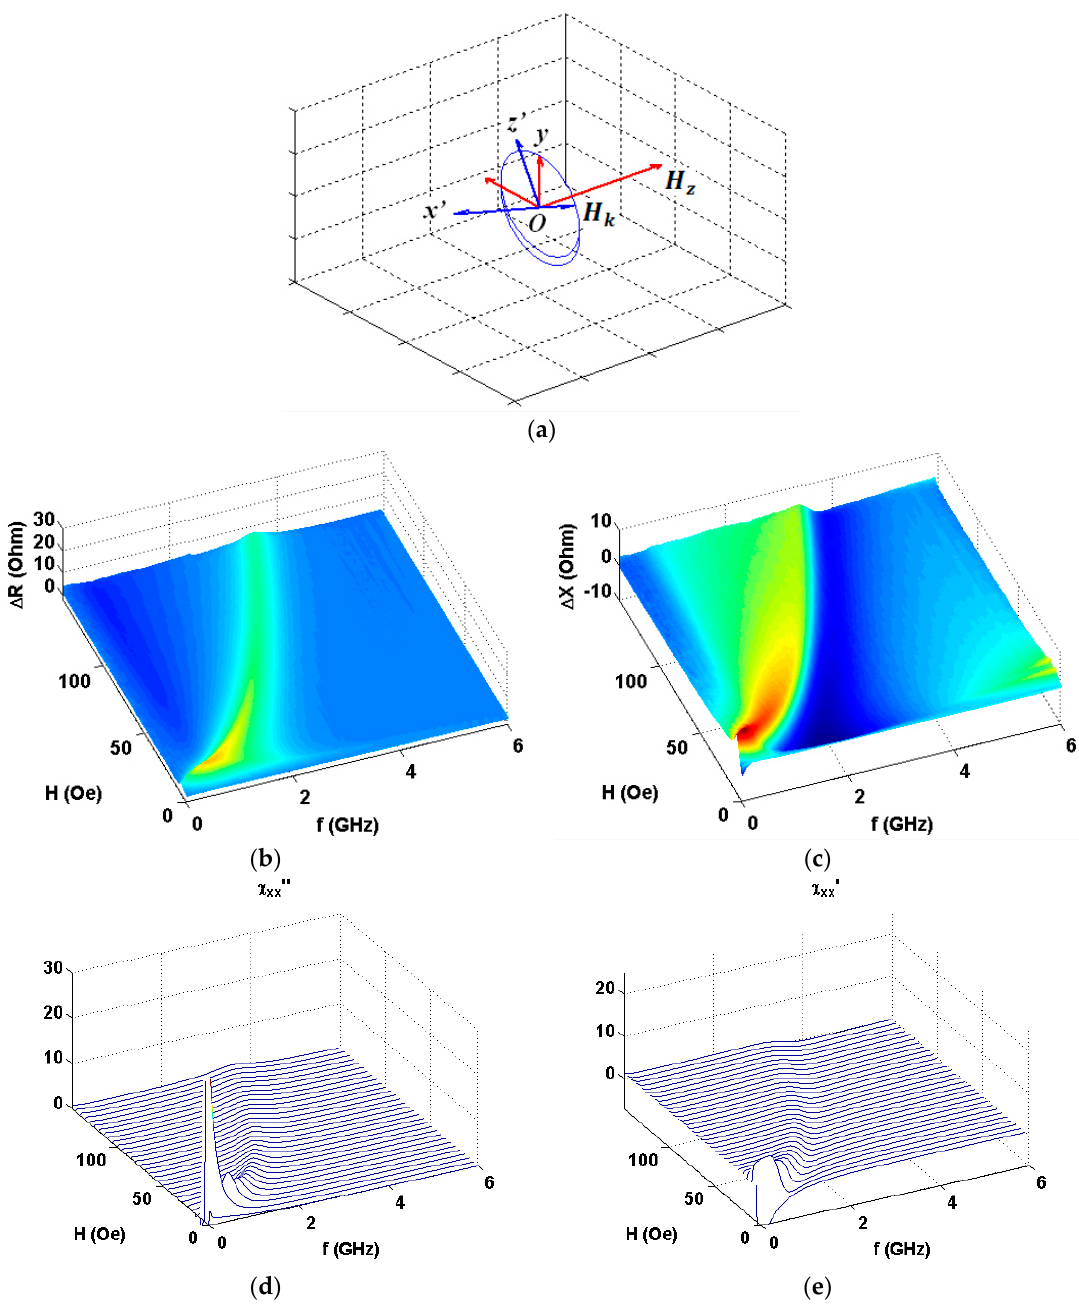
Figure 6. Coordinate system for vector H directed under the angle α = 30° with respect to high frequency field h ( a ). Experimental data for the applied field and frequency dependences of the real ( b ) and imaginary ( c ) parts of the impedance of GMI element. Model calculations for imaginary ( d ) and real ( e ) parts of the susceptibility tensor corresponding to the real and imaginary parts of the impedance variations accordingly.